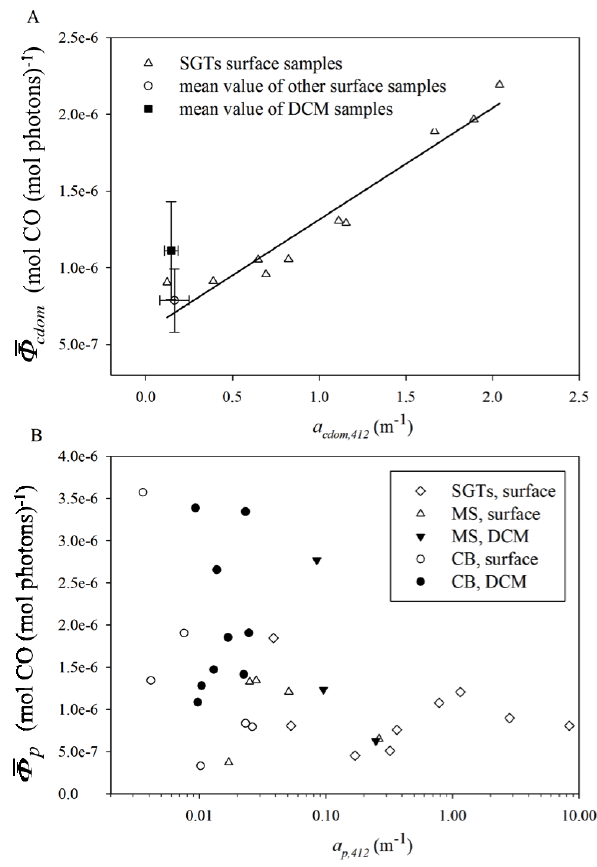
F p Fig. 4. Relationships between ¯ 8 cdom and a cdom , 412 (A) and be-